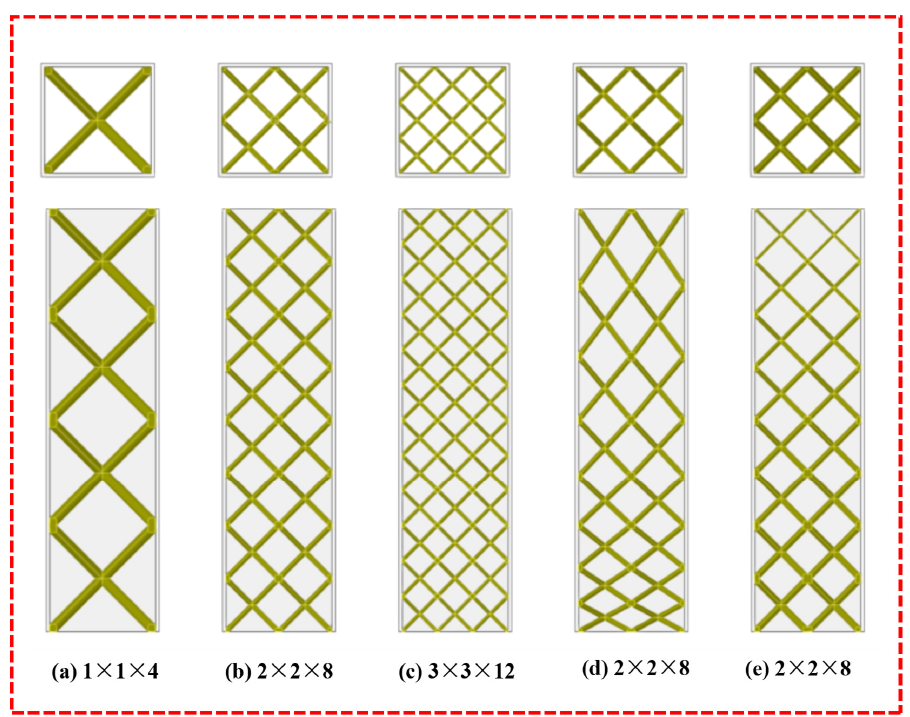
Figure 3. Main and top views of the lattice structure with different cell